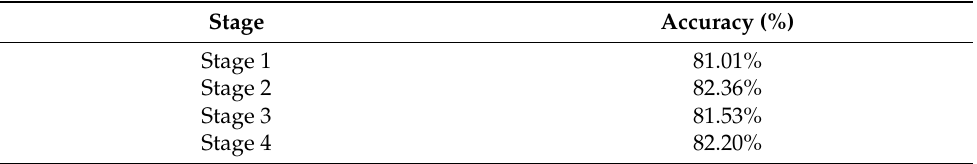
Table 5. Accuracy of CBAM being placed at different